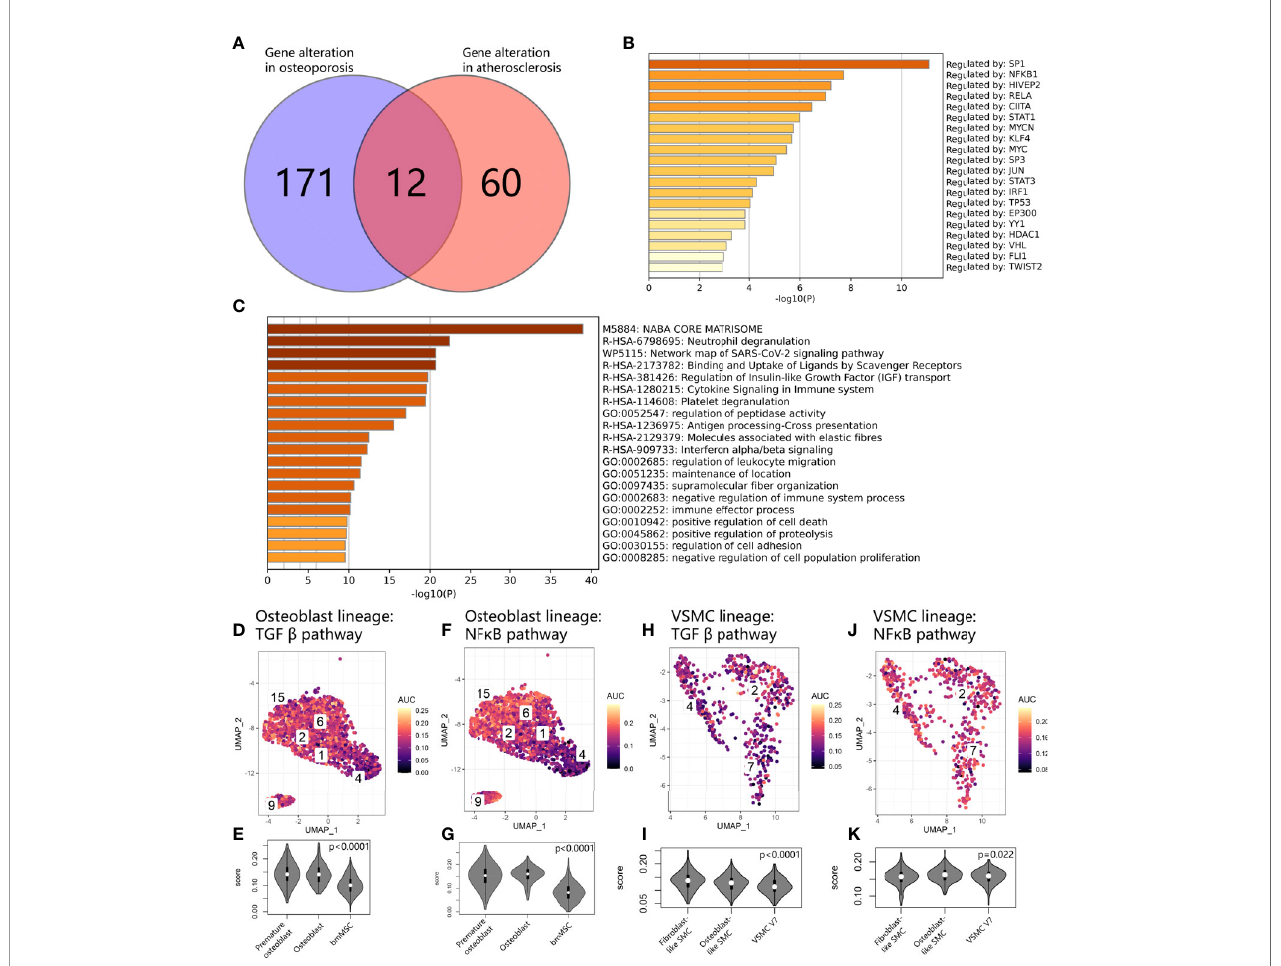
FIGURE 8 | Common expression patterns at the crossroads of osteoblast and vascular SMC cell state transitions. (A) Venn diagram showing gene alterations between delayed exit from the premature state in the osteoblast lineage and osteogenic and fi brogenic transition in vascular SMCs. (B) Bar plot for the top-ranked transcriptome factors on alteration expression at the crossroads of the osteoblast and vascular SMC cell state transitions. (C) Bar plot for the top-ranked gene set enrichment in altered expression at the crossroads of the osteoblast and vascular SMC cell state transitions. (D, F, H, J) Scatter plot showing the distribution of AUCell scores of gene sets, including the TGF b pathway (D – H) and NF k B (F – J) , in osteoblast and vascular SMC lineages. Yellow indicates a high score, and purple indicates a low score. (E, G, I, K). Violin plots exhibiting the AUCell scores of gene sets, including the g TGF b pathway (E – I) and NF k B (G – K) , in osteoblast and vascular SMC